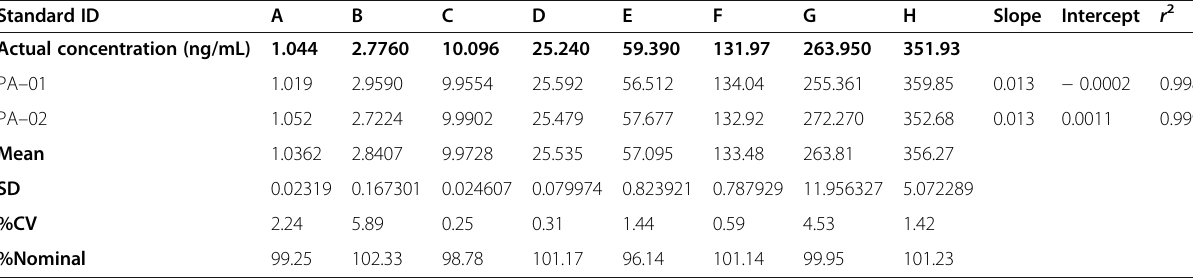
Table 5 Back-calculated concentrations of bexarotene for calibration curve